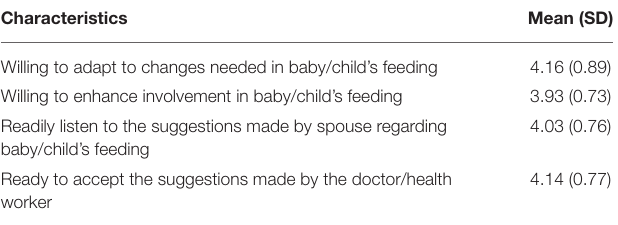
TABLE 3 | Attitude of the study participants toward enhanced involvement in IYCF ( N =